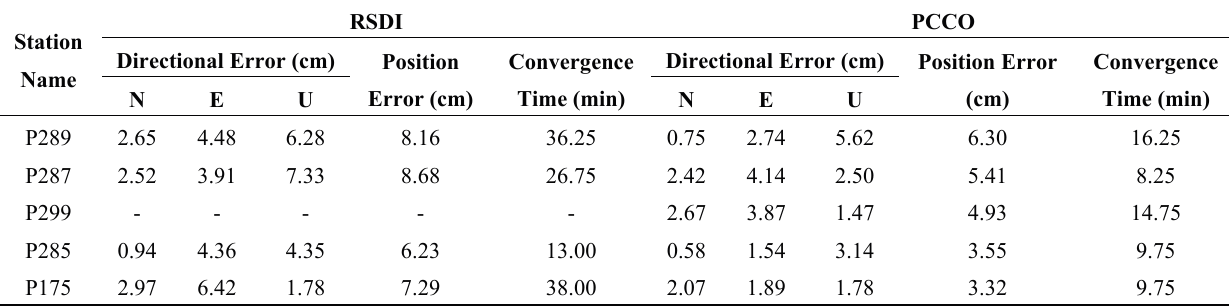
Table 1. RMS of positioning error and convergence time of RSDI and PCCO.